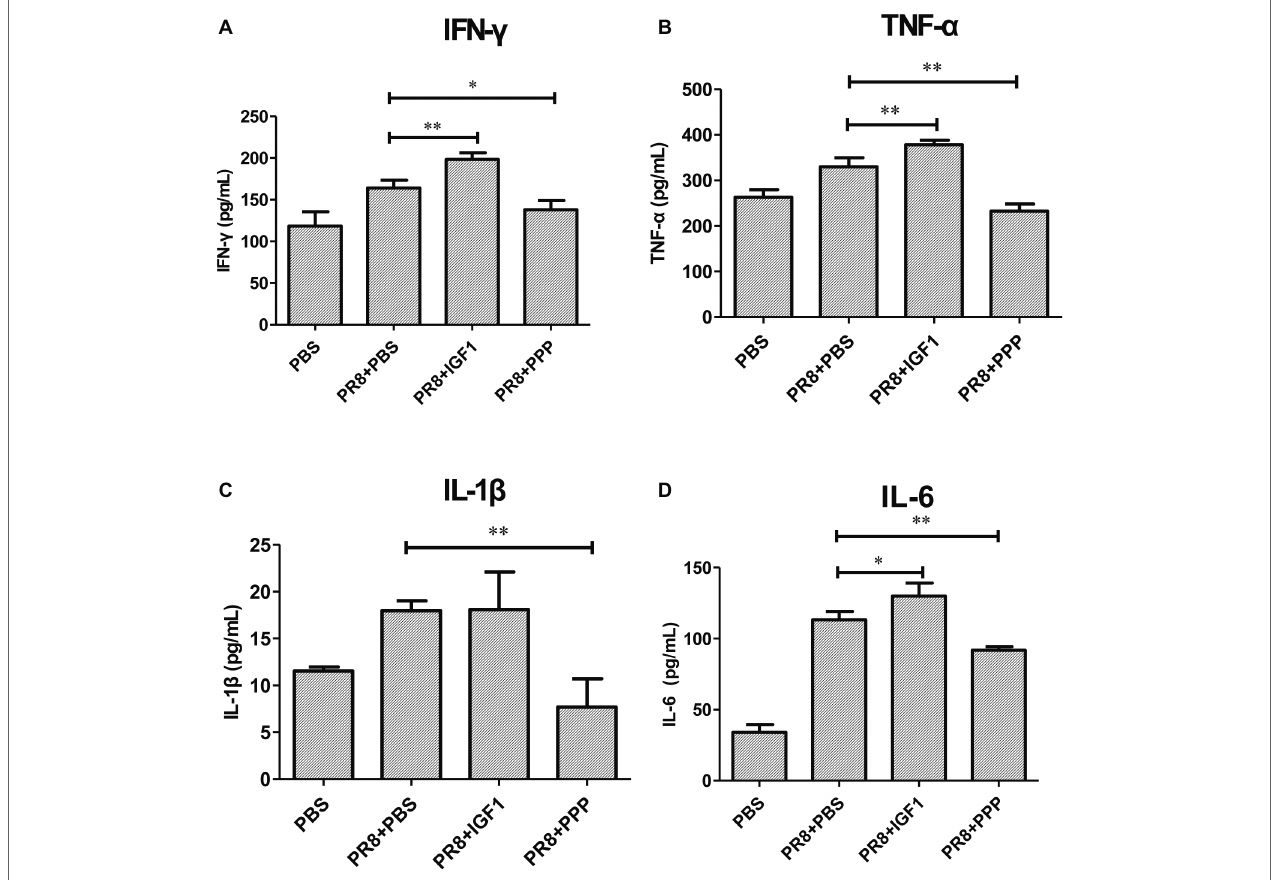
FIGURE 6 | Cytokine expression in BALB/c mice after PR8 infection. Groups of BALB/c mice ( n = 6, females, 6–8 weeks) were intranasally infected with PR8 (50LD 50 ), treated with IGF1 or PPP, and at day 5 post-infection, the mice serum were examined for changes in (A) IFN- γ mRNA, (B) TNF- α mRNA, (C) IL-1 β mRNA, and (D) IL-6 mRNA. Data were the means ± SD from three independent experiments. * p < 0.05; ** p < 0.01 vs. PR8 + PBS group by t